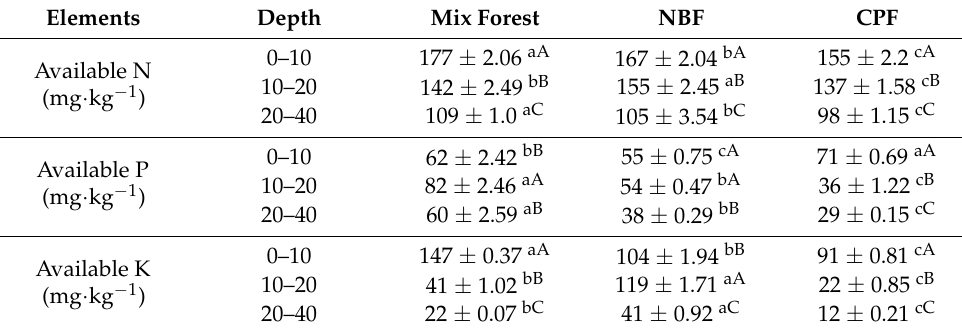
Table 4. Available soil nutrients in different forest types at different soil